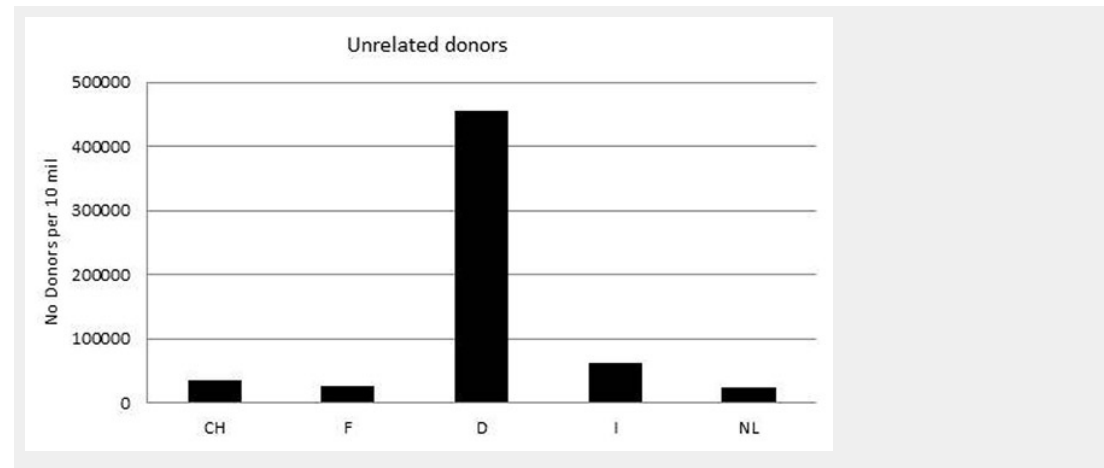
Figure 2 Number of registered unrelated donors in the national registries of the five countries studied corrected for population size, presented as donors per 10 million inhabitants(CH: Switzerland, F: France, D: Germany, I: Italy, NL: the